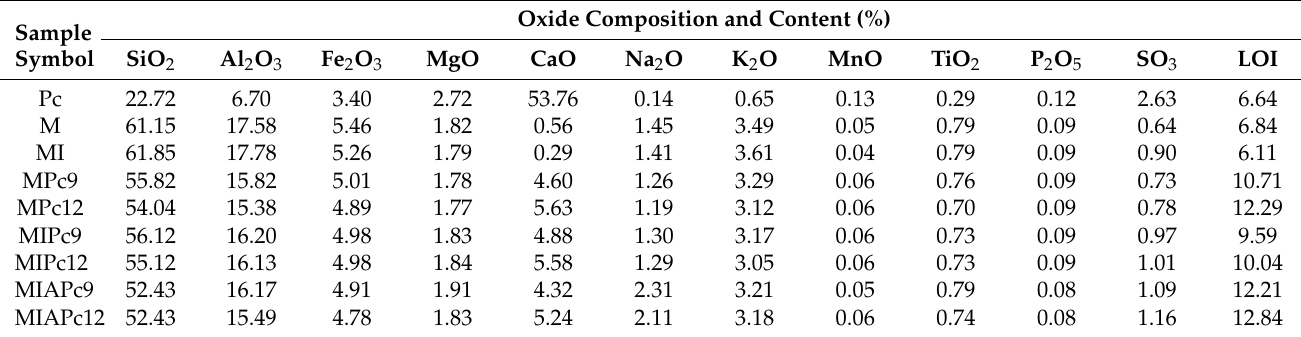
Table 5. XRF results of different samples (LOI: loss on ignition). Oxide Composition and Content